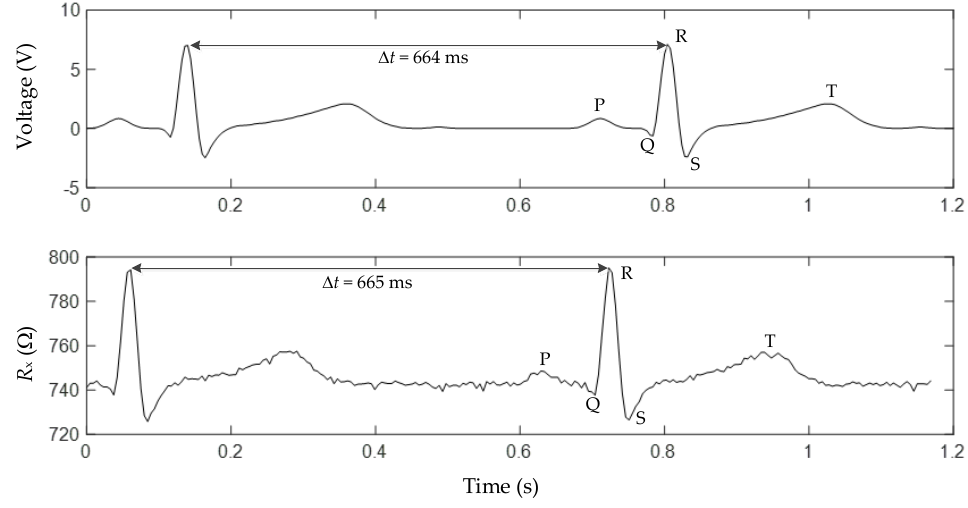
Figure 9. Results from Experiment C: an ECG signal of 1.5 Hz was measured with the oscilloscope (upper trace) and the DIC (bottom trace); the signals were not acquired simultaneously.